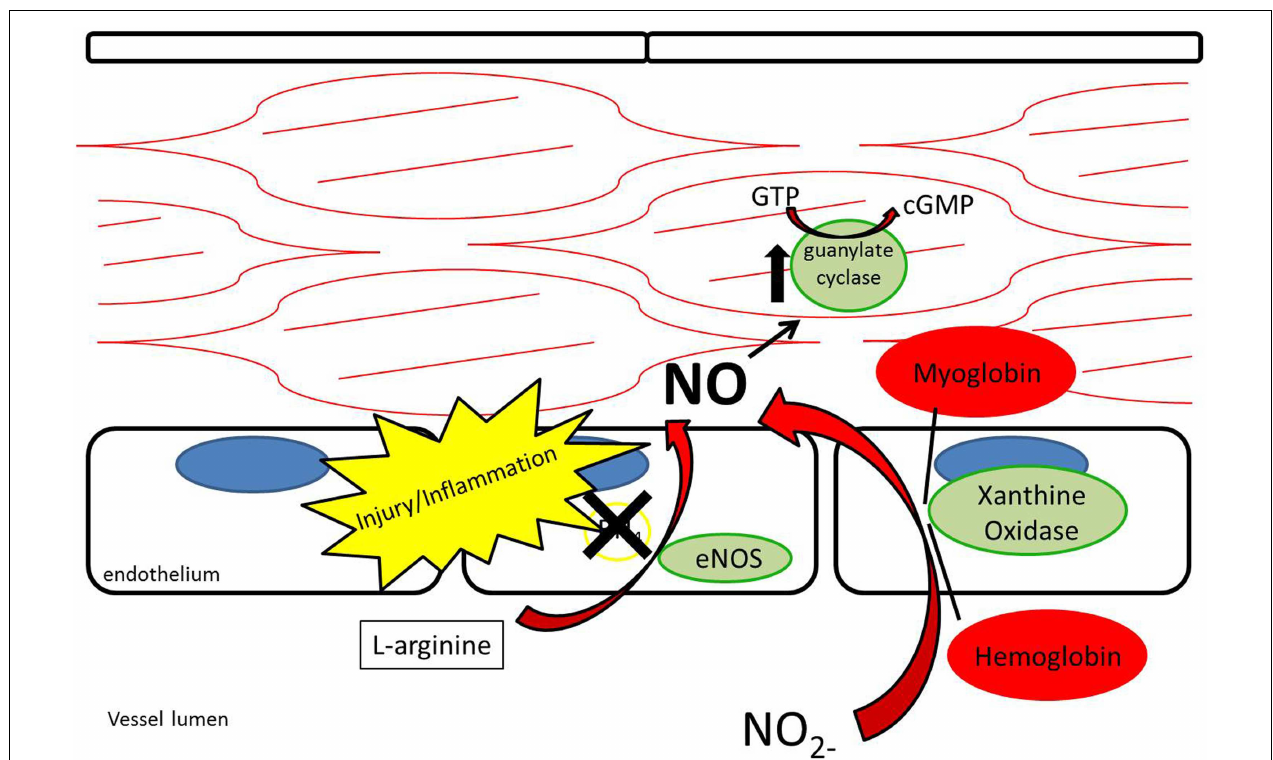
FIGURE 4 | Nitrite reduction by xanthine oxidoreductase, myoglobin, hemoglobin, and protonation results in nitric oxide production, especially under conditions of hypoxia and acidemia